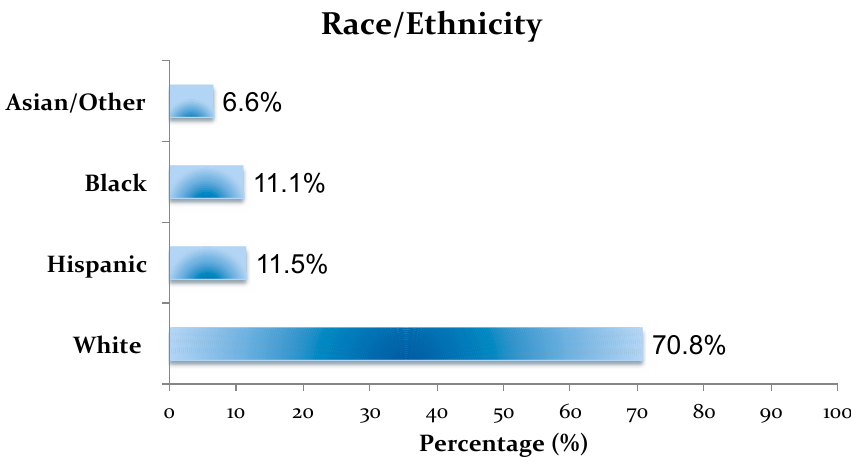
Figure A2. Primary Payment Method differences among SIH cases.